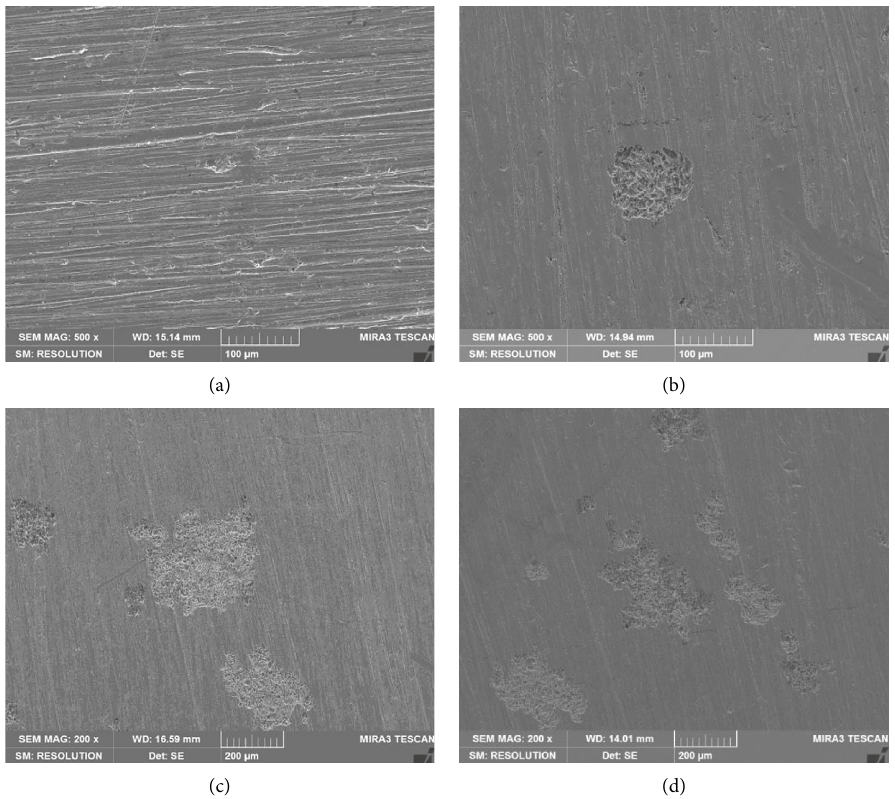
Figure 2: The surface morphology of solution-treated specimens after immersion corrosion for different times: (a) 48h, (b) 72h, (c) 120h, (d) 168h.